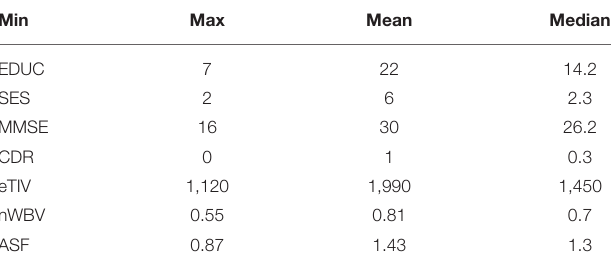
TABLE 3 | Min, max, and median values of each